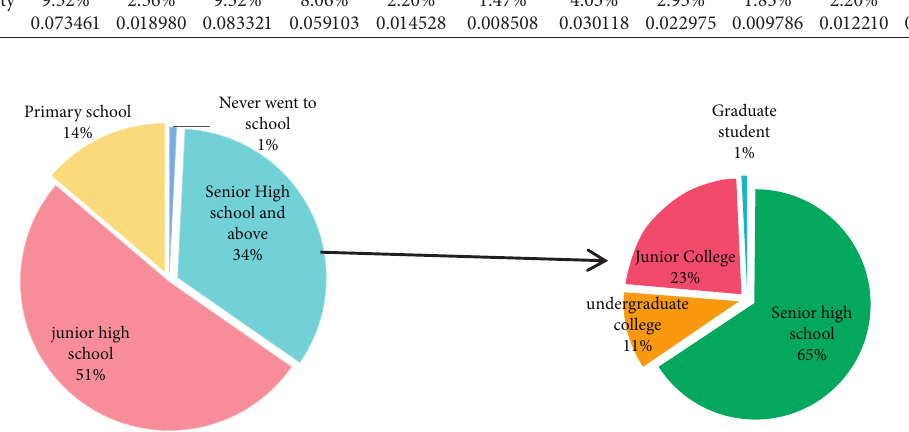
Figure 3: The average educational attainment composition of employed persons by W mine from 2005 to 2018. Table 8: Violating labor discipline unsafe behaviors.